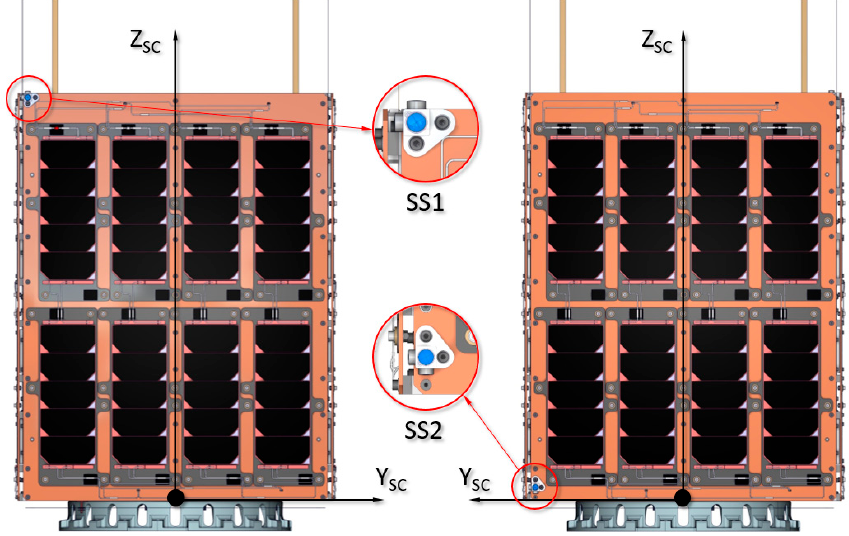
Figure 2. Front and rear view of the UPMSat-2 satellite showing the reference system and the position of the SS1 and SS2 sun sensor sets.